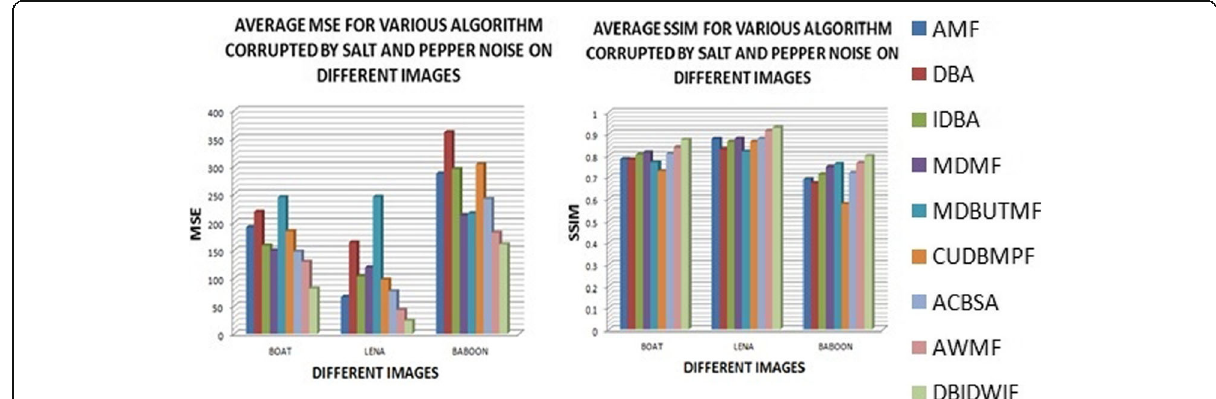
Fig. 14 Average MSE and SSIM for various algorithm corrupted by salt and pepper noise on different